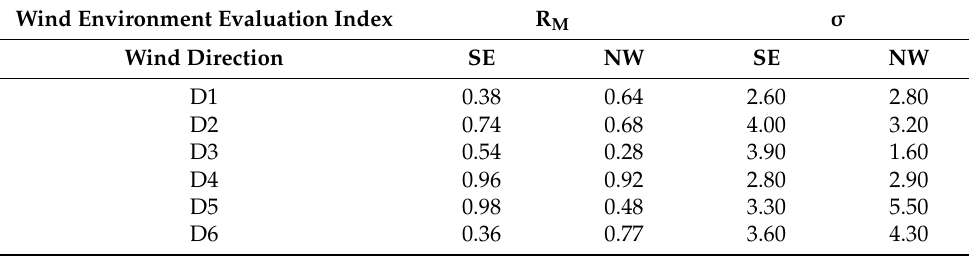
Table 9. Average wind speed ratio and wind speed dispersion at different wind directions for building undulation.